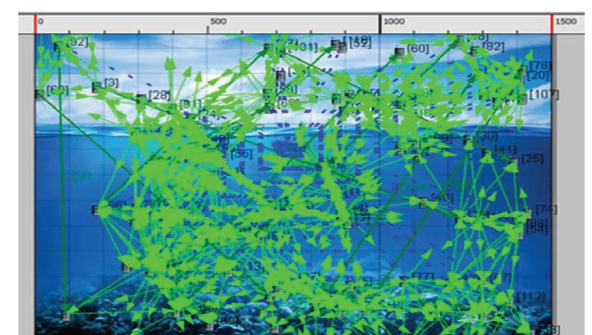
Figure 6: Runtime proposed underwater wireless communication with 120 nodes in X - Y visualization. Figure 7: Runtime proposed underwater wireless communication with 120 nodes in 3D